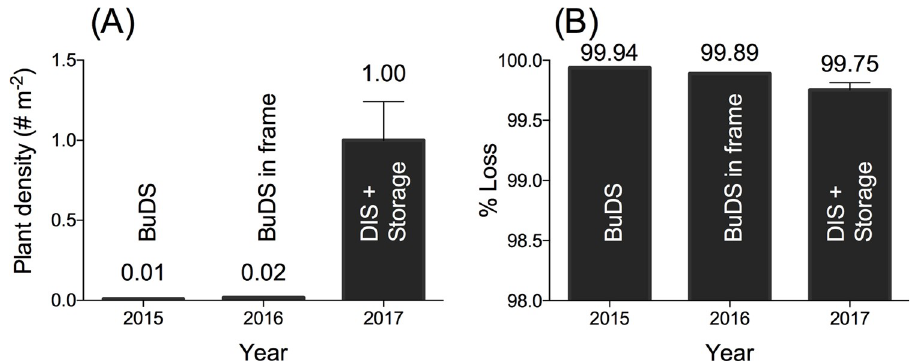
Fig 4. Comparison results Uithuizen experiment (2017) with results of previous (2015–2016) years. (A) Plant densities (m -2 ) (B) Loss rates